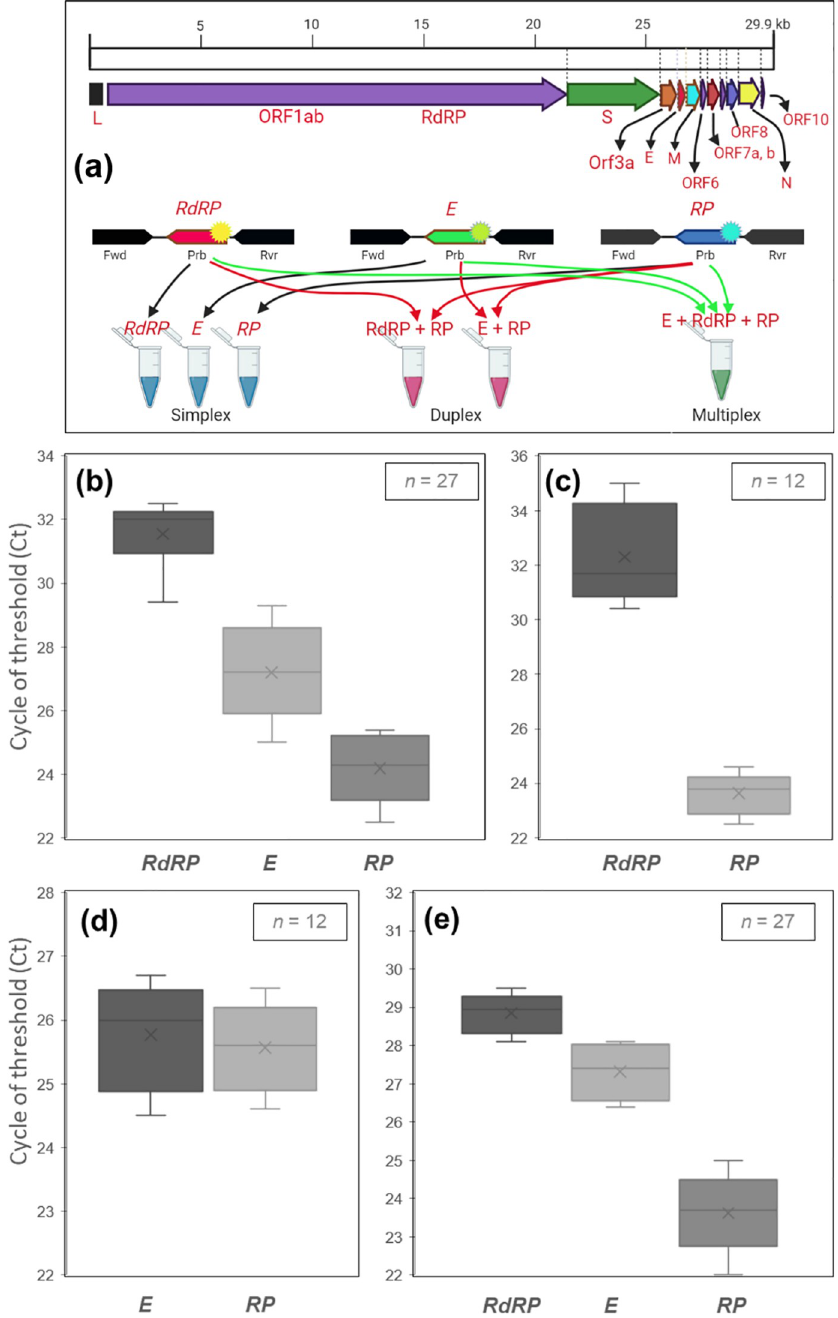
Fig 1. Experimental design and the cycle threshold (Ct) value of rRT-PCR repeats. (a) Genome organization of SARS-CoV-2 and selected gene/probe sets. (b) Simplex assay targeting RdRP , E , and RP genes in separate reaction tubes. Multiplex or duplex assay amplifies two genes simultaneously: (c) RdRP and RP , (d) E and RP . (e) Multiplex or triplex assay that targets two viral ( RdRP and E ) and one human internal control ( RP ) gene simultaneously.